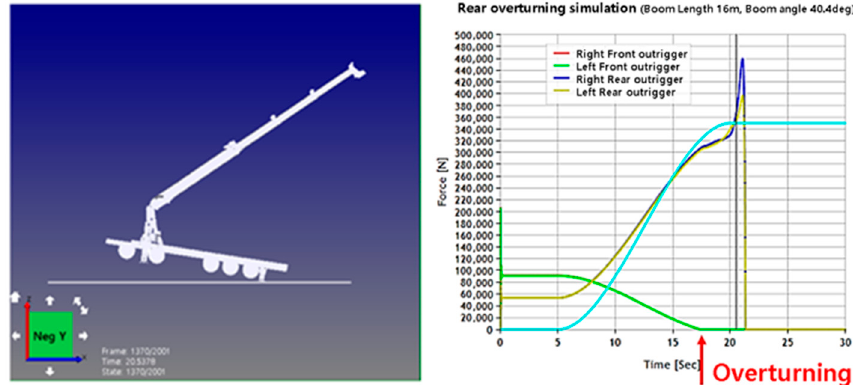
Figure 4. The simulation result of rear overturning.